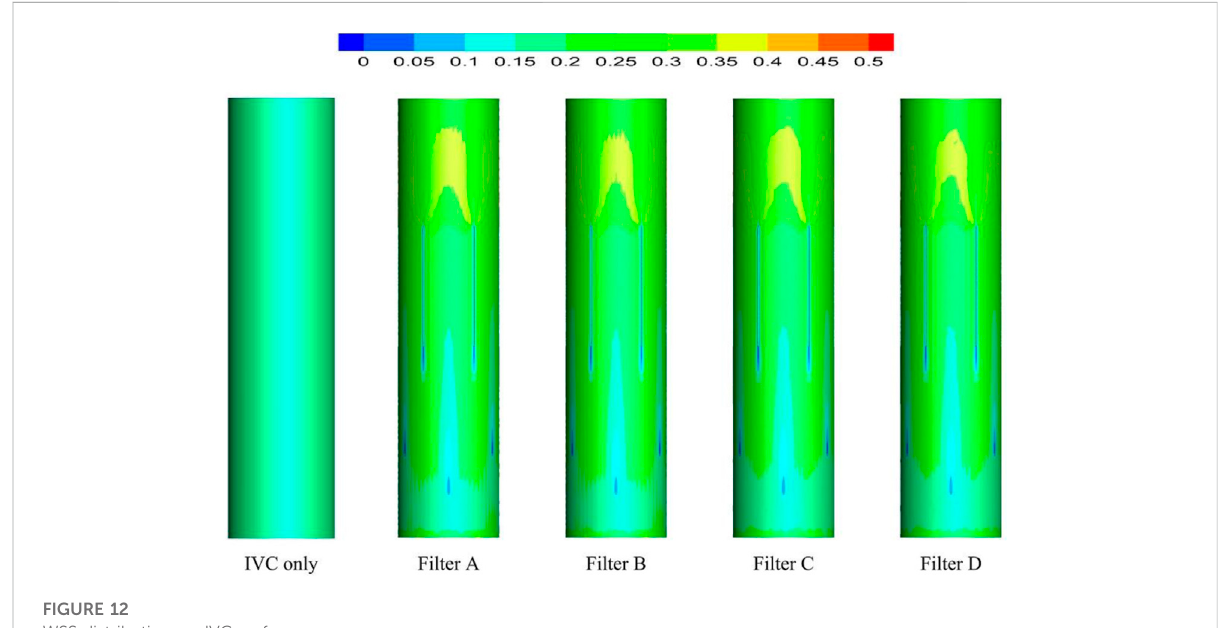
FIGURE 12 WSS distribution on IVC